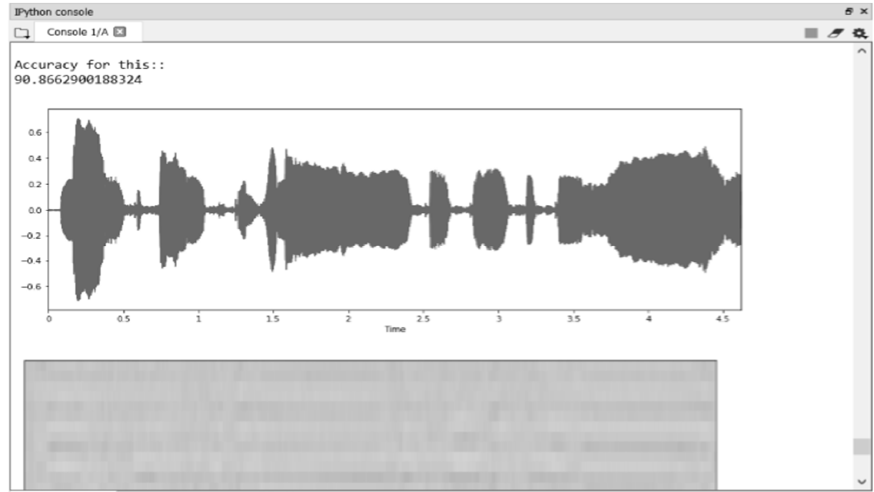
Figure 4. Spectrogram and accuracy generated for Speaker 1.